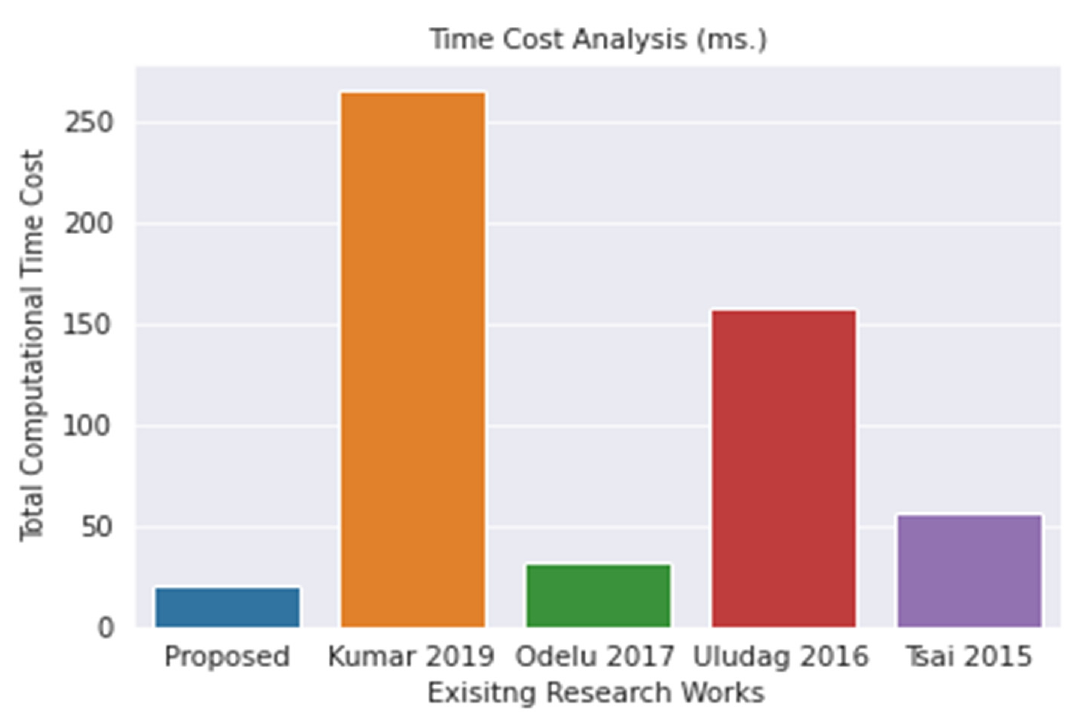
Figure 7. Comparative performance analysis between proposed and existing works in terms of time cost analysis [8,9,12,13].